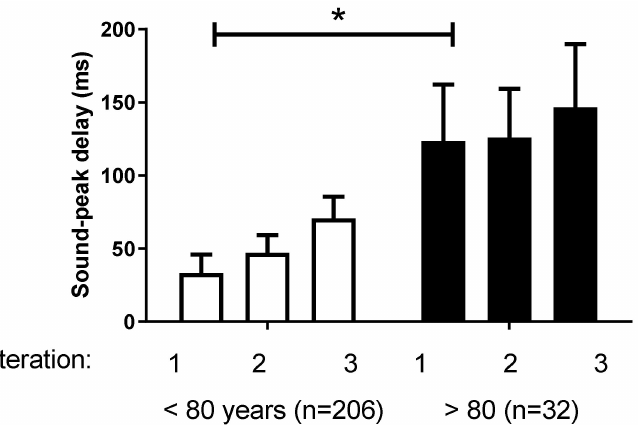
Figure 3. Effect of age and repetition on PST. Younger patients had a lower PST compared to older individuals (MMRM, * p = 0.0150 for the effect of age, p = 0.1156 for the effect of iteration, and p = 0.8561 for interaction). PST: peak-sound